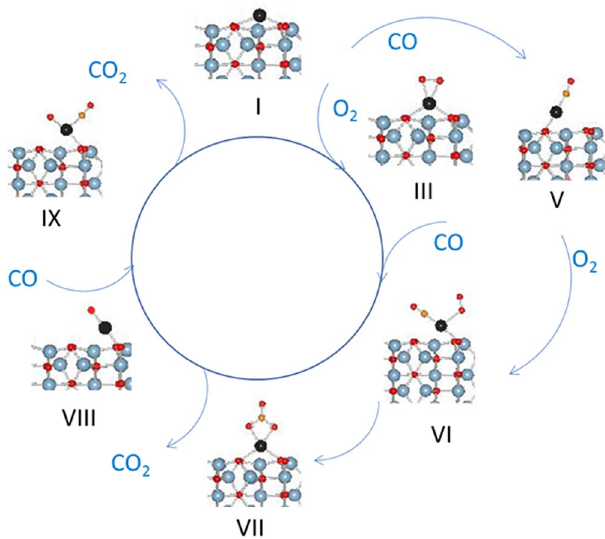
Figure 2. CO oxidation cycle on a single supported Pd adatom.